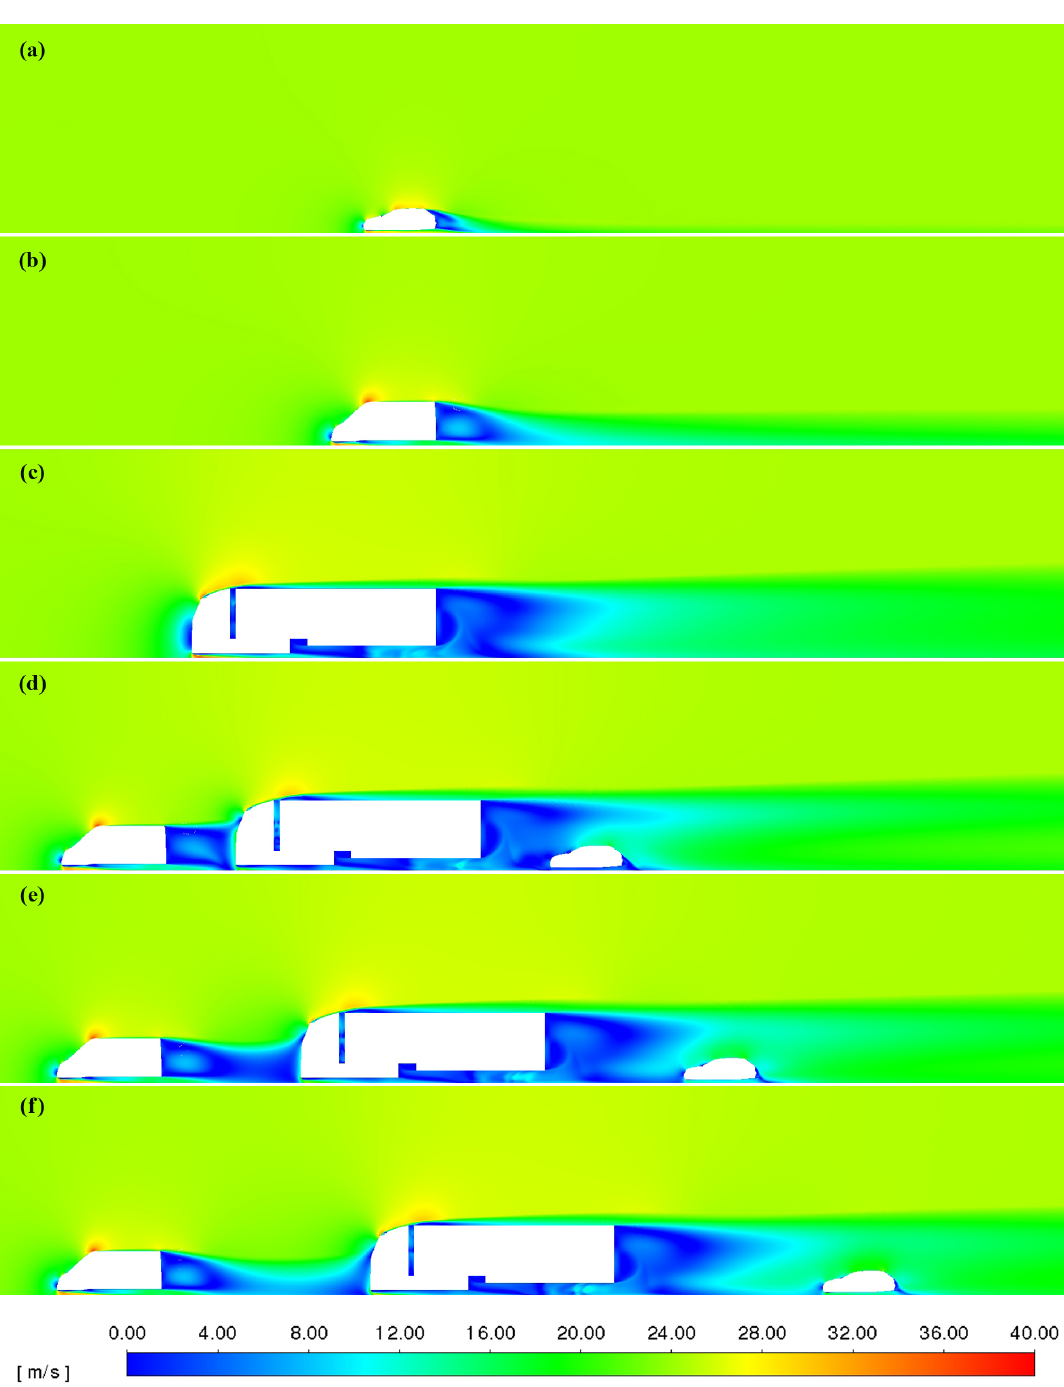
Figure 11. A fragment of velocity filed around the vehicles. View at the symmetry plane. ( a ) Single car, ( b ) single van, ( c ) single truck, ( d ) column of vehicles with a spacing of 4 m, ( e ) column of vehicles with a spacing of 8 m, ( f ) column of vehicles with a spacing of 12